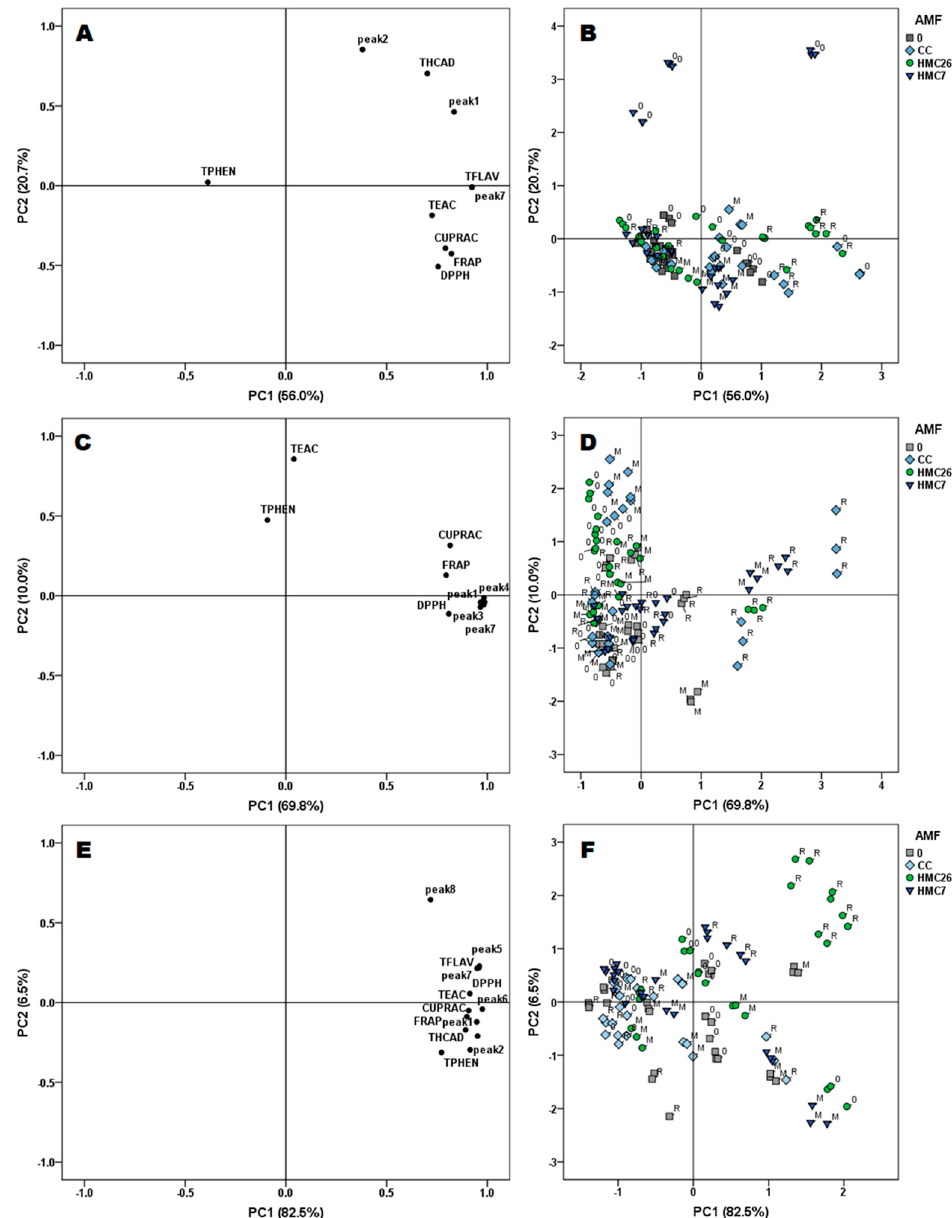
Figure 5. Scores of the principal component (PC) for the experimental variables ( left ) determined in leaves of three genotypes of Solanum tuberosum and the grouping of the samples according to the PCs distribution ( right ). VR808 ( A , B ), CB2011-509 ( C , D ), CB2011-104 ( E , F ). Where: peak 1: 5-caffeoylquinic acid; peak 2: caffeoylquinic acid; peak 3: quercetin-3-glucosylrutinoside; peak 4: quercetin-dihexoside; peak 5: quercetin-pentoside-rutinoside; peak 6: no identified; peak 7: quercetin- rutinoside; peak 8: kaempferol-rutinoside; TFLAV: total flavanols; THCAD: total hydroxycinnamic acids; TPHEN: concentration of total phenolics according to Folin–Ciocalteu method; TEAC: Trolox equivalent antioxidant capacity; CUPRAC: reducing antioxidant capacity of the cupric ion; DPPH: antioxidant activity of the DPPH radical; FRAP:, ferric reducing antioxidant power; 0: without AMF; CC: Claroideoglomus claroideum ; HMC26: Claroideoglomus lamellosum ; HMC7: Funneliformis mosseae ; M: MONCUT and R: ReflectXtra .